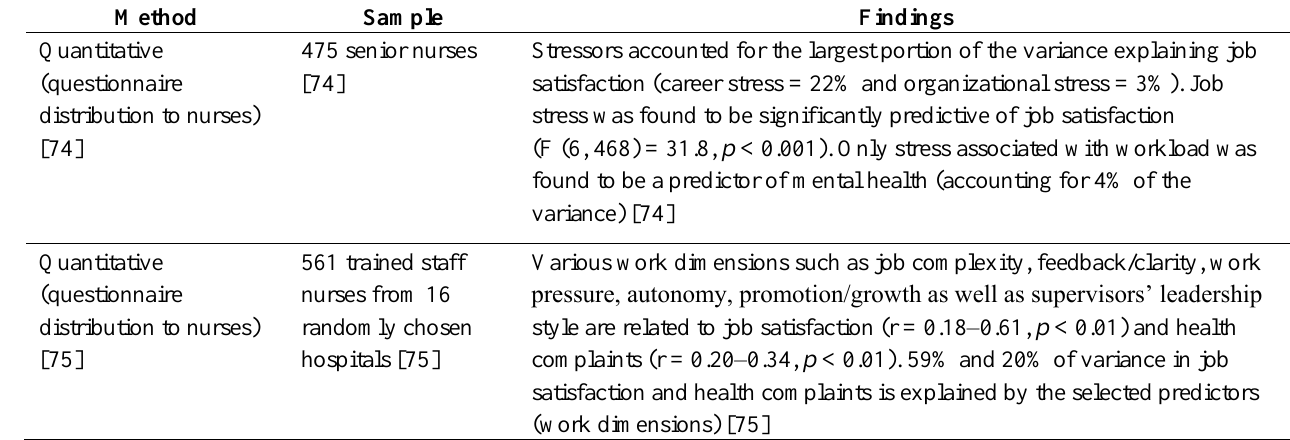
Table 6. Method, sample and findings of identified